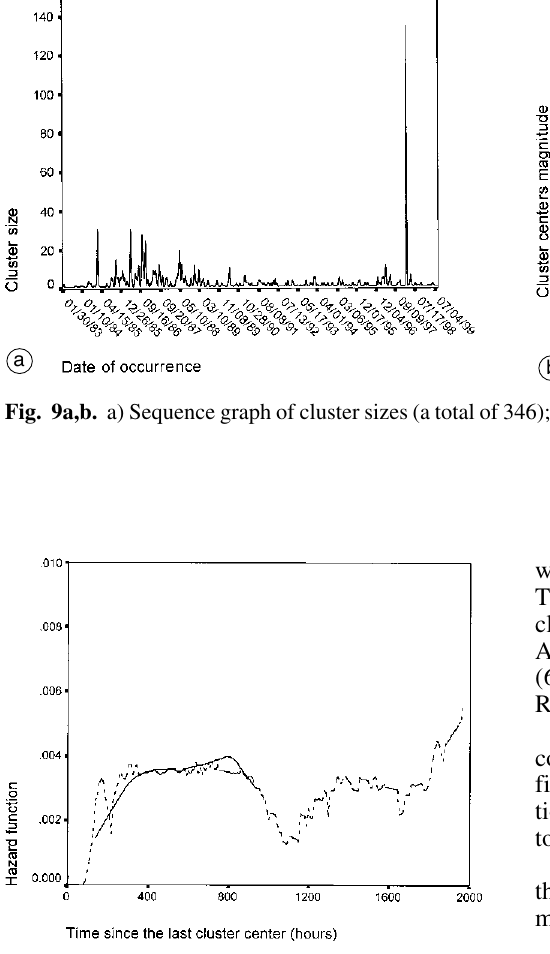
Fig. 10. Hazard estimation of time intervals between cluster centers with global bandwidth (solid line) and local bandwidths (dashed line).